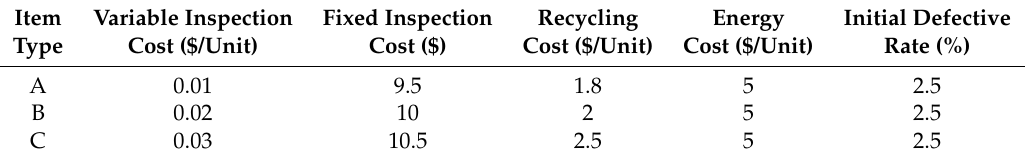
Table 3. Data related to the imperfect